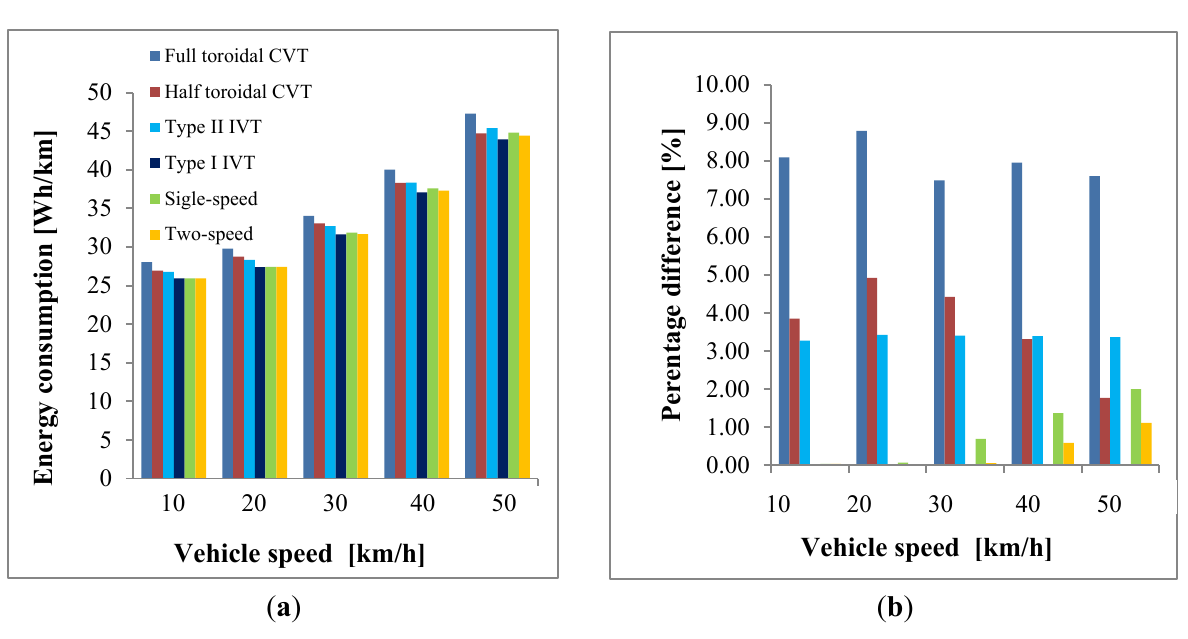
Figure 13. ( a ) Absolute energy consumption at constant speed and ( b ) relative percentage